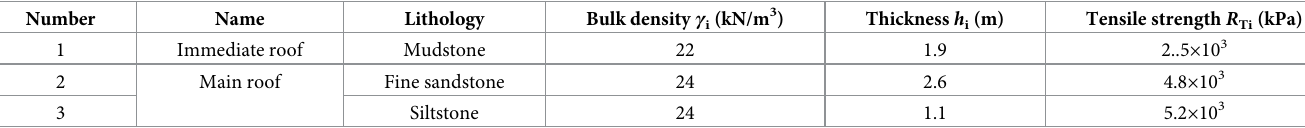
Table 10. Physical and mechanical parameters of roof strata above No.9 coal seam.